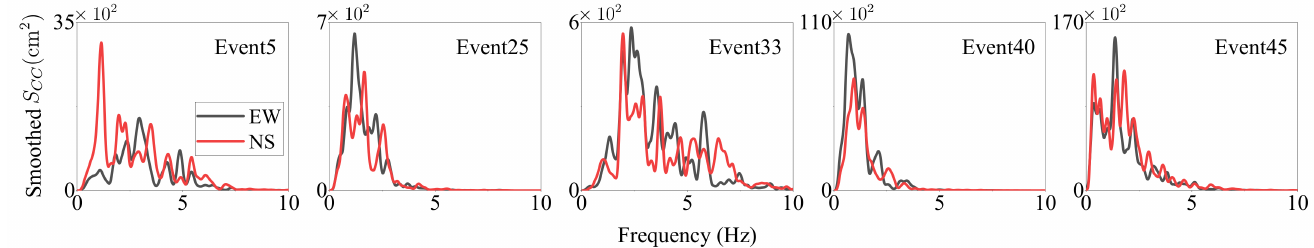
Figure 7. Smoothed energy spectrum of the horizontal components.